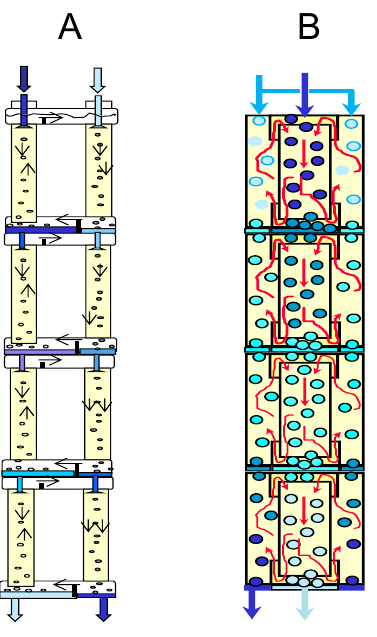
Figure 8. Multistage three-phase extraction apparatus, consisting of two-column stages ( A ) and a multistage two-chamber extraction column ( B ).